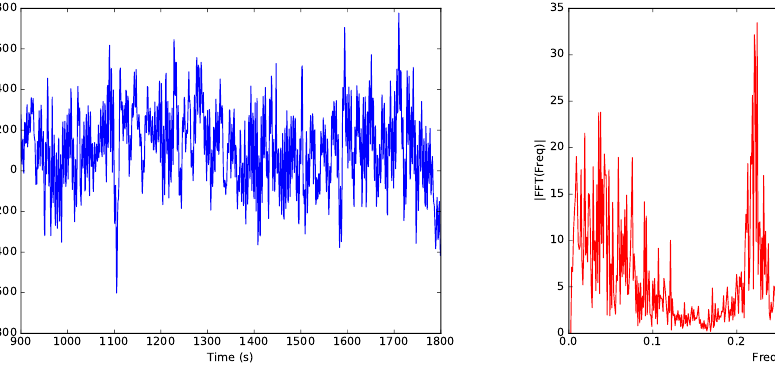
( b ) Fast-Fourier transform of lift across the cylinder